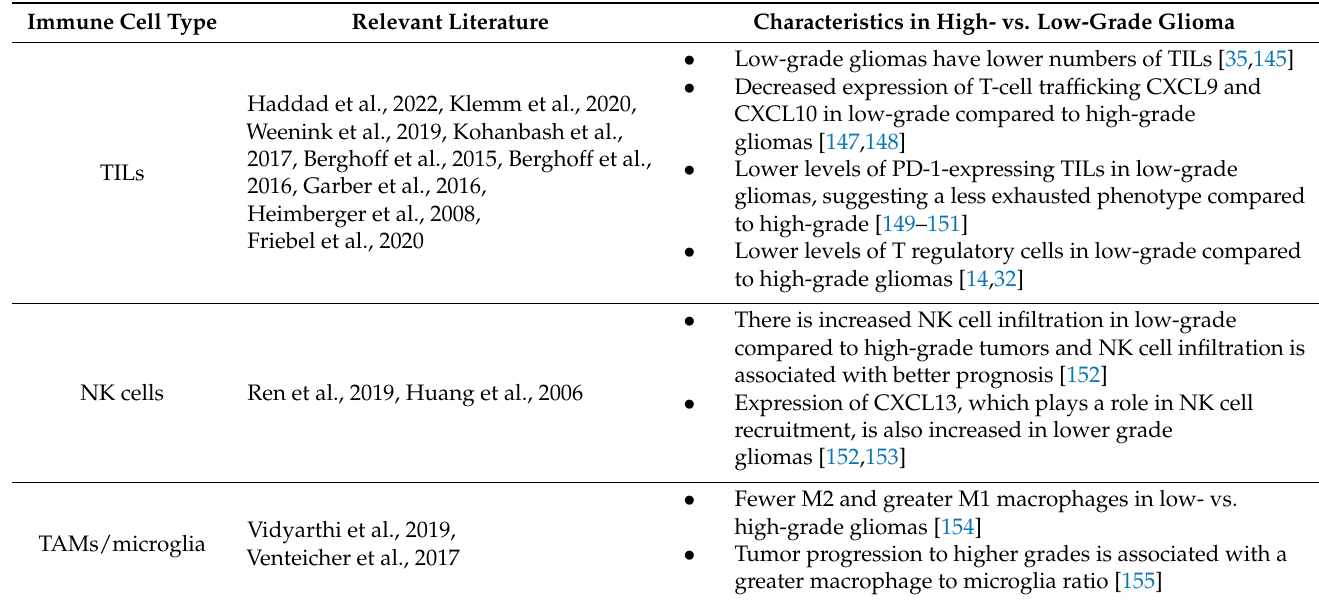
Table 2. Key differences in the immune cell infiltration of high- and low-grade